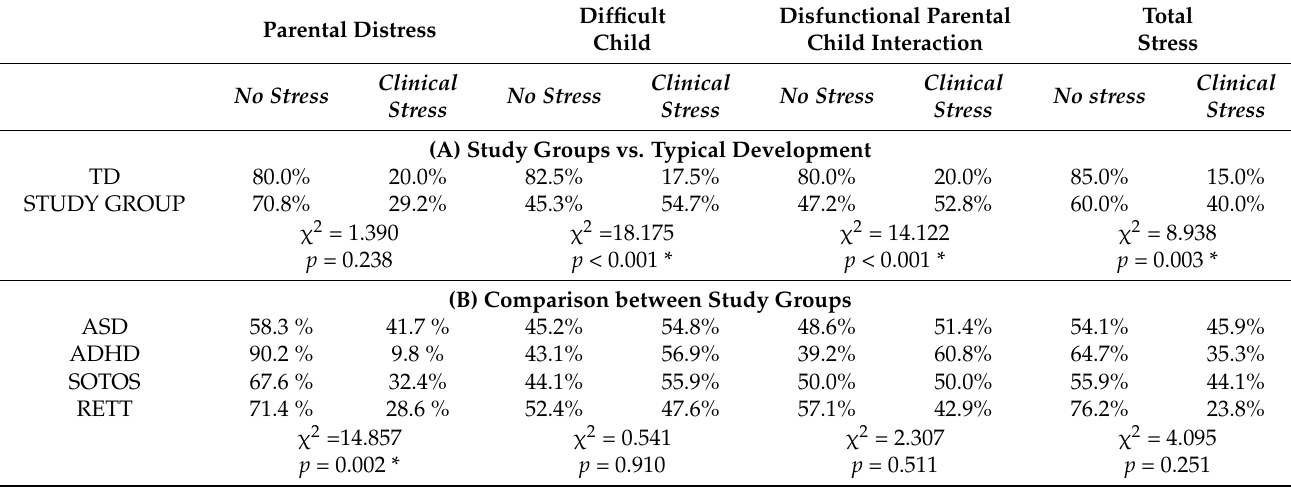
Table 2. Stressed vs. Non